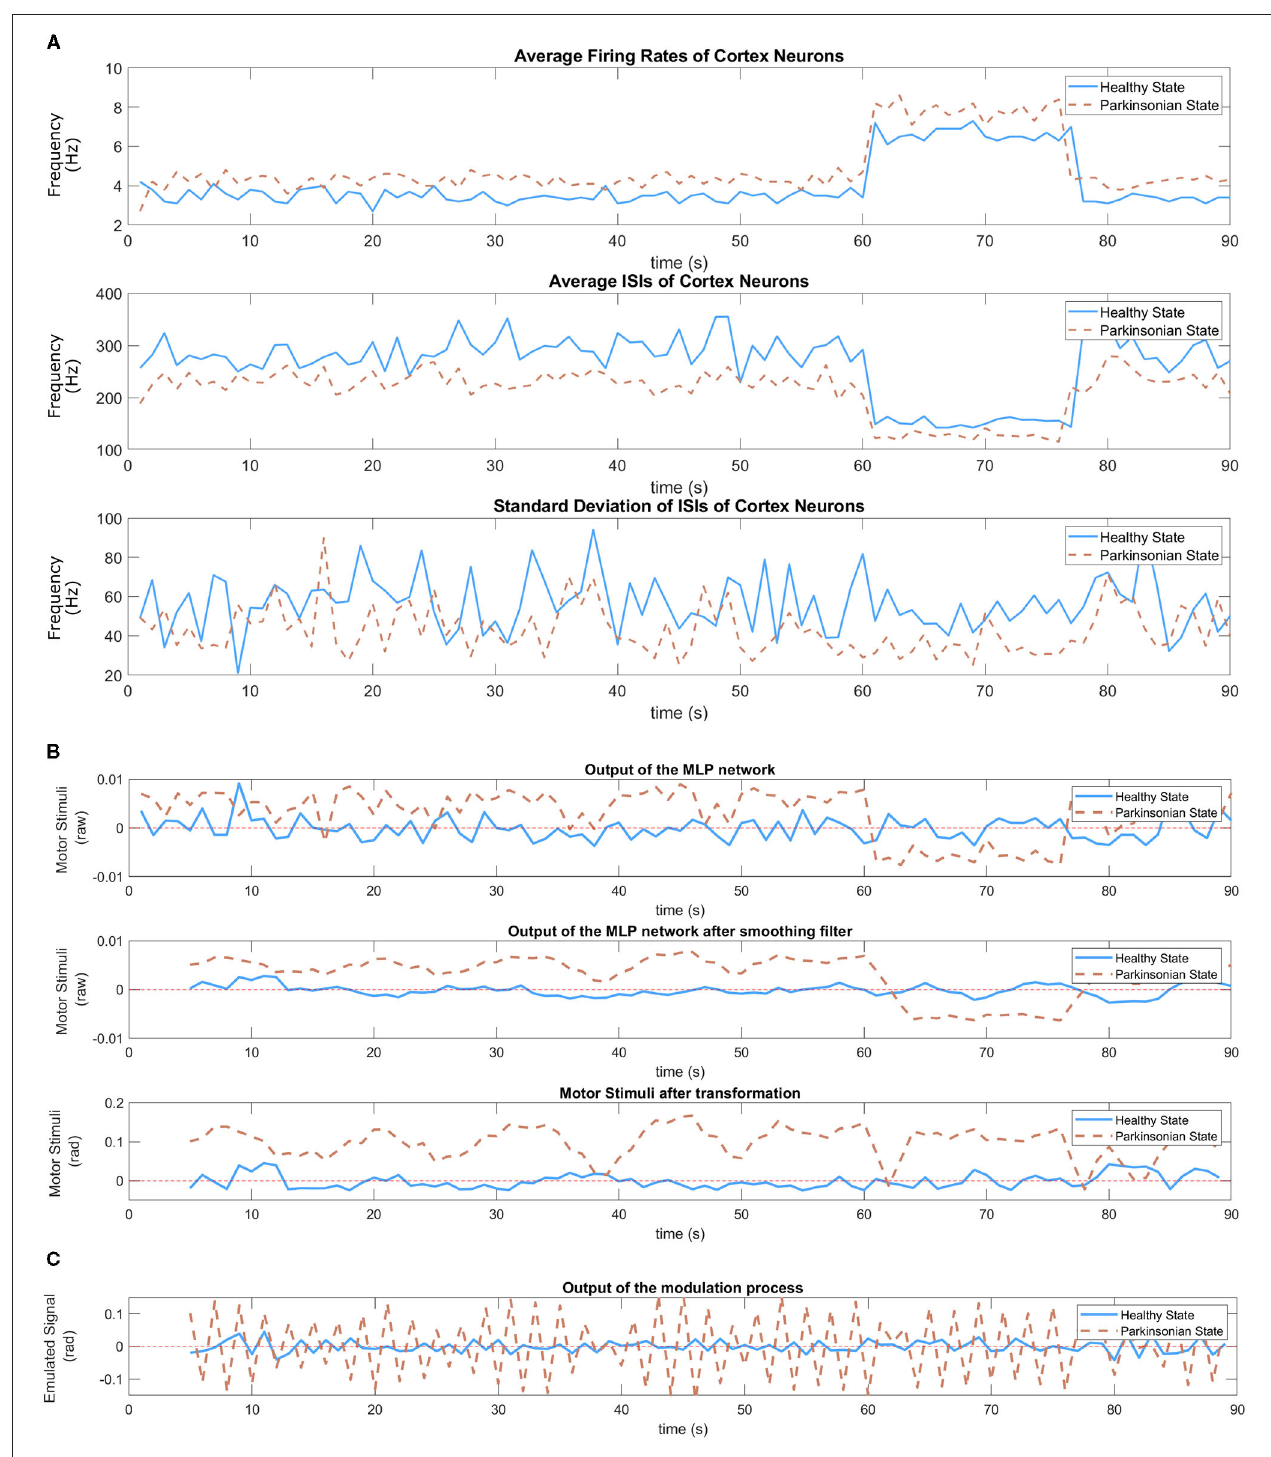
FIGURE 11 | In (A) , inputs of the MLP network—average firing rate (Equation 1), average of ISIs (Equation 3), and standard deviation of ISIs (Equation 4) of cortical neurons) during the performance of the task. Two experiments following the same sequence of balls (yellow, green, and purple) were executed, one for each condition of the model. The variation of those stimulus can be easily observed in those graphics. (B) Shows the response of the trained MLP network ( Figure 8 ) to the dynamic of cortical neurons under both conditions of the model. A smoothing filter (Equation 8) is applied to the output of the MLP network in order to reduce the oscillation that is common on neural signals. Then, a linear transformation (Equation 9) adjust the value to proper ranges allowing the disturbance to be visible during the execution of the task without compromising the motors of the robot. In (C) , the graphic shows the output of the modulation process which corresponds the emulated signal.